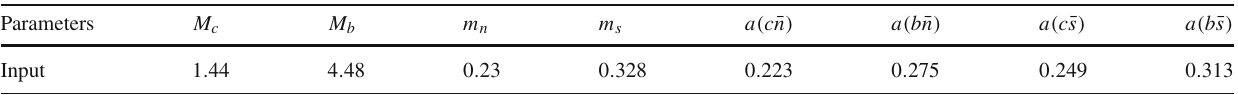
Table 1 The effective masses (in GeV) of the quark masses and the string tensions a (in GeV 2 ) of the D / D s and B / B s mesons in Ref. [29] Parameters M c M b m n